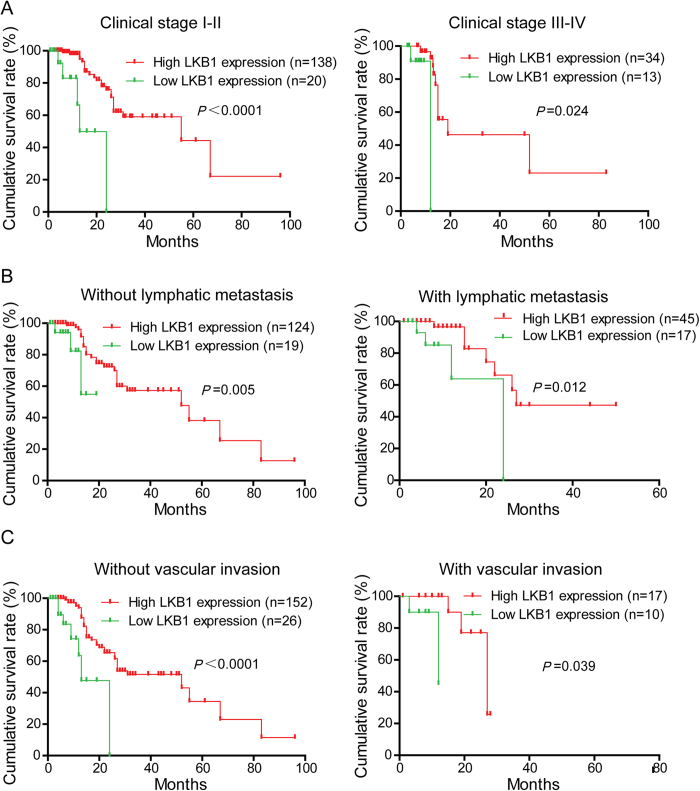
Correlation between LKB1 expression and overall survival rate in PDAC patients is independent of clinical stage, status of lymphatic metastasis and vascular invasion. A Comparisons of overall survival between in LKB1 low expression and LKB1 high expression in early clinical stage (I-II) cohort and in advanced clinical stage (III-IV) cohort. B Comparisons of overall survival between in LKB1 low expression and LKB1 high expression in patients with or without lymph node metastasis. C Comparisons of overall survival between in LKB1 low expression and LKB1 high expression in patients with or without vascular invasion. P-values were calculated by log-rank test.